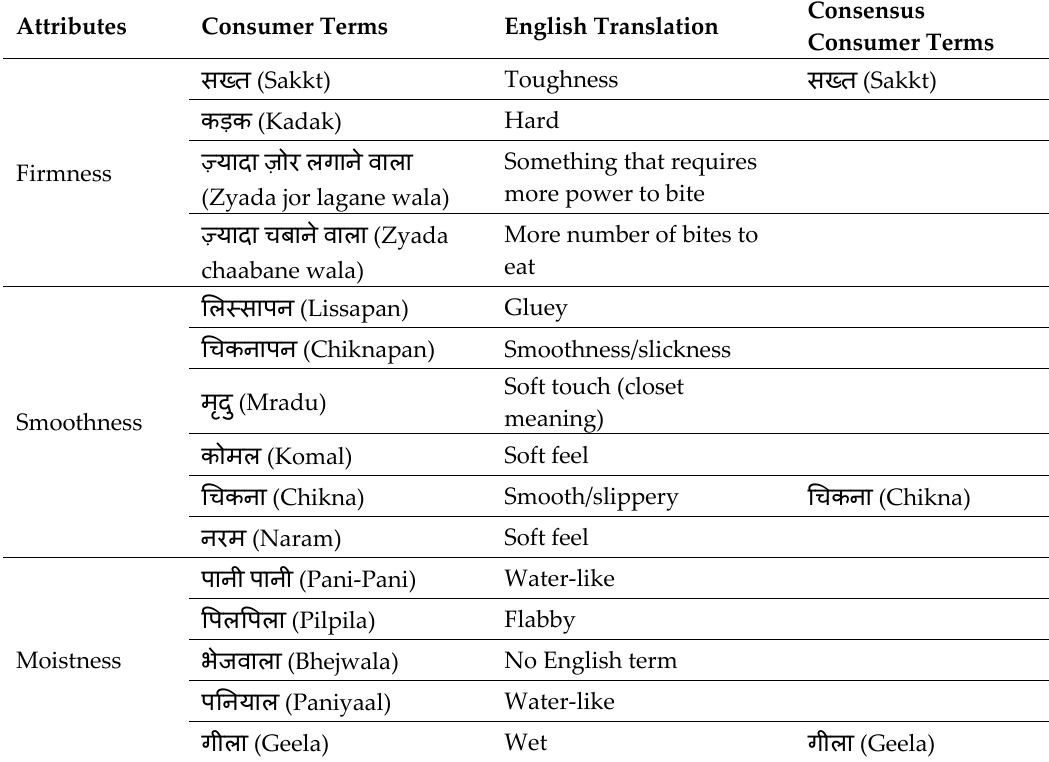
Table 5. Consumer texture terms provided by the Hindi-speaking group (India).